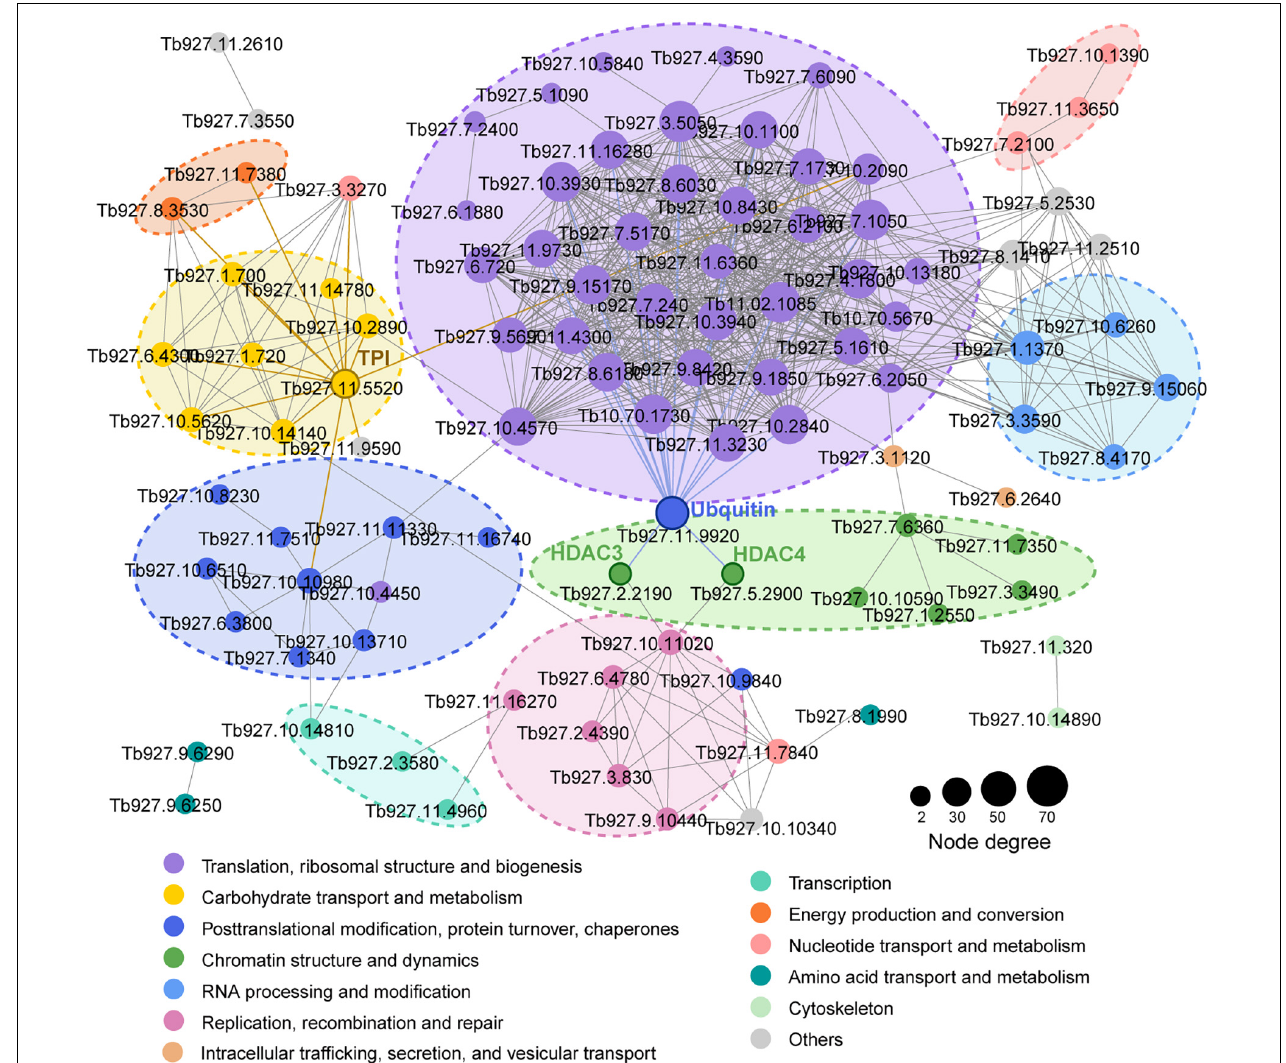
FIGURE 2 | Kla protein interaction network. Protein-protein interaction networks for all Kla proteins. Interactive proteins are connected by lines. Different colors represent functional protein clusters based on KOG classification. Circle sizes are proportional to node